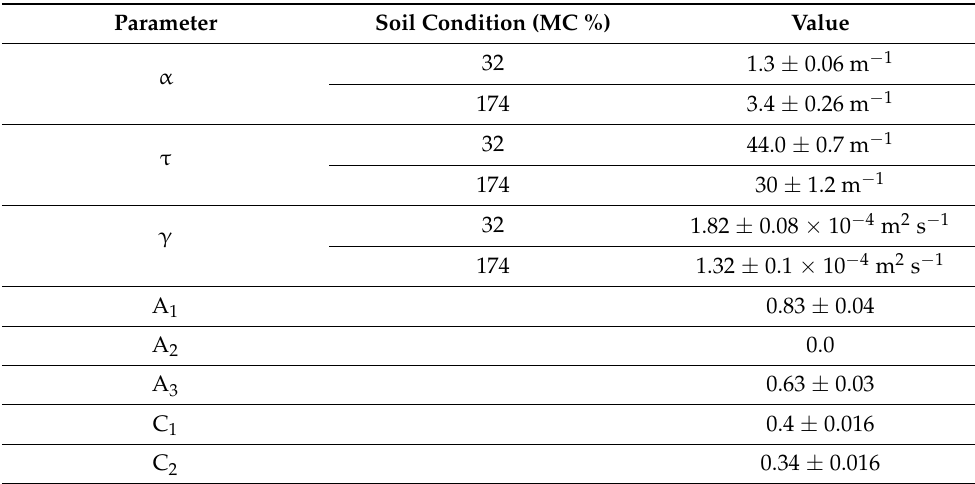
Figure 8. Temperature distribution along the ceramic applicator in the peak heating lobe of the vertical plane (38 mm from the central plane) at the different depths after MW heating of soil with moisture contents of ( top ) 32, ( middle ) 89 and ( bottom ) 174%. (F = 2.45 GHz, p = 3.5 kW, time of MW heating—15 s, T o = 23 ◦ C, applied energy 53 kJ). Table 3. Soil parameter values used to model soil temperature during FTIR experiments (Note: uncertainty values represent ± the standard error for these